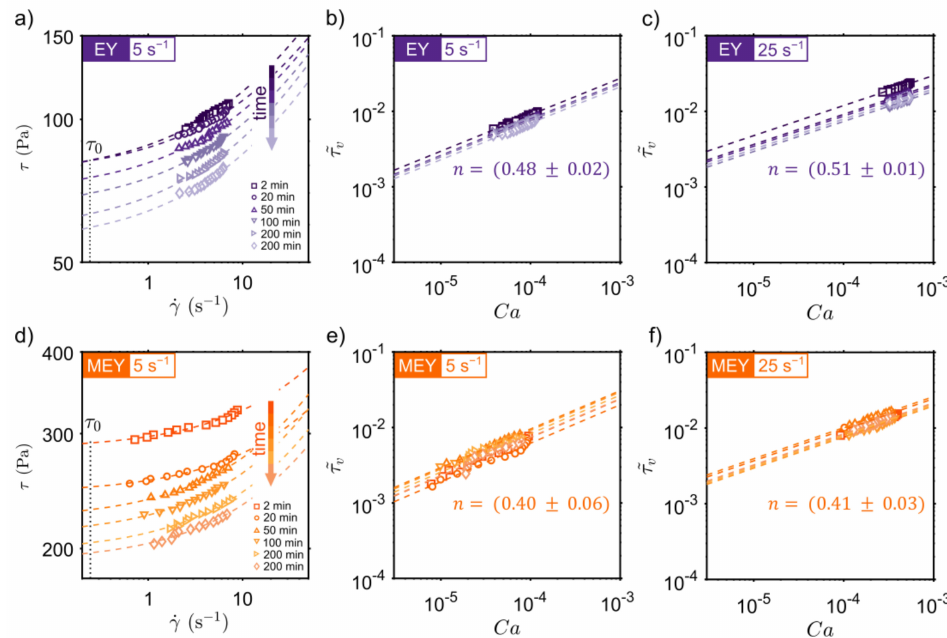
(cid:0) . (cid:1) γ ( r ) , and of ( b , c ) or ( e , f ) dimensionless